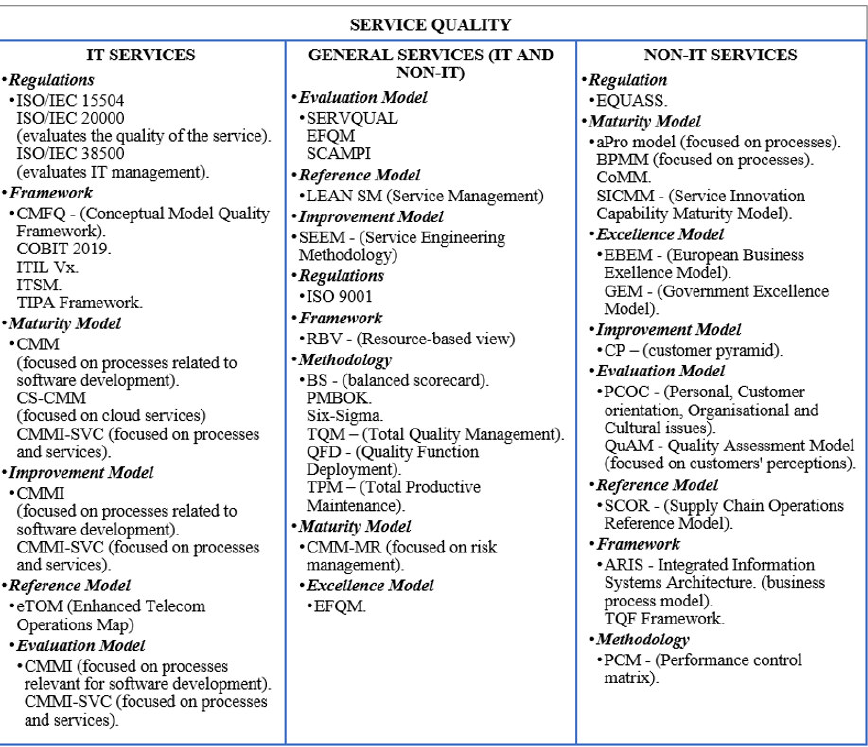
Fig. 3 . Classification of the proposals found in the